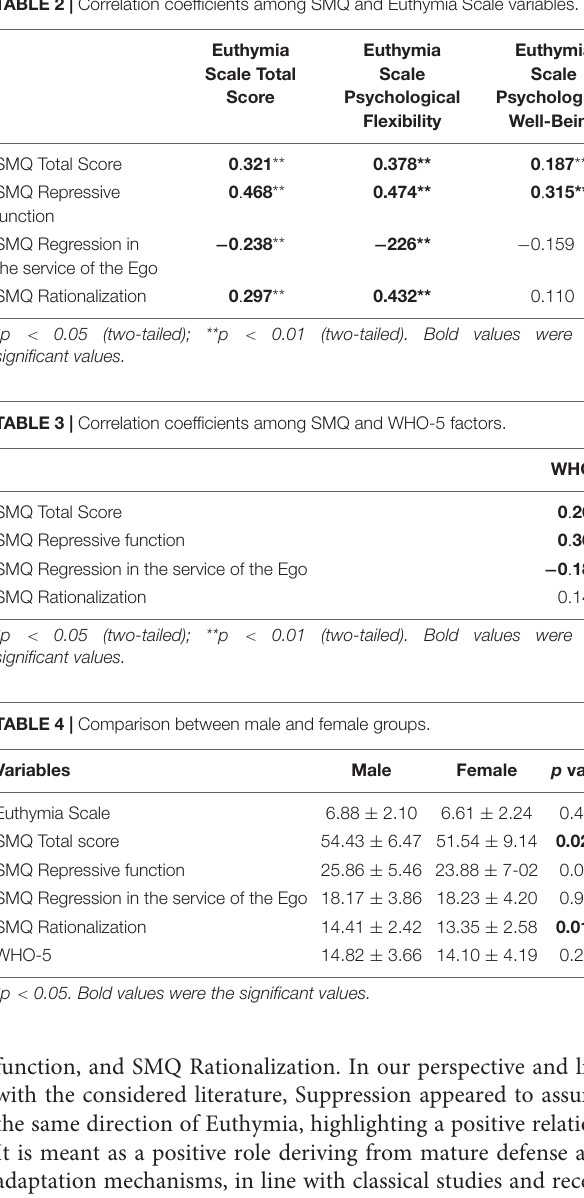
TABLE 2 | Correlation coefficients among SMQ and Euthymia Scale variables.